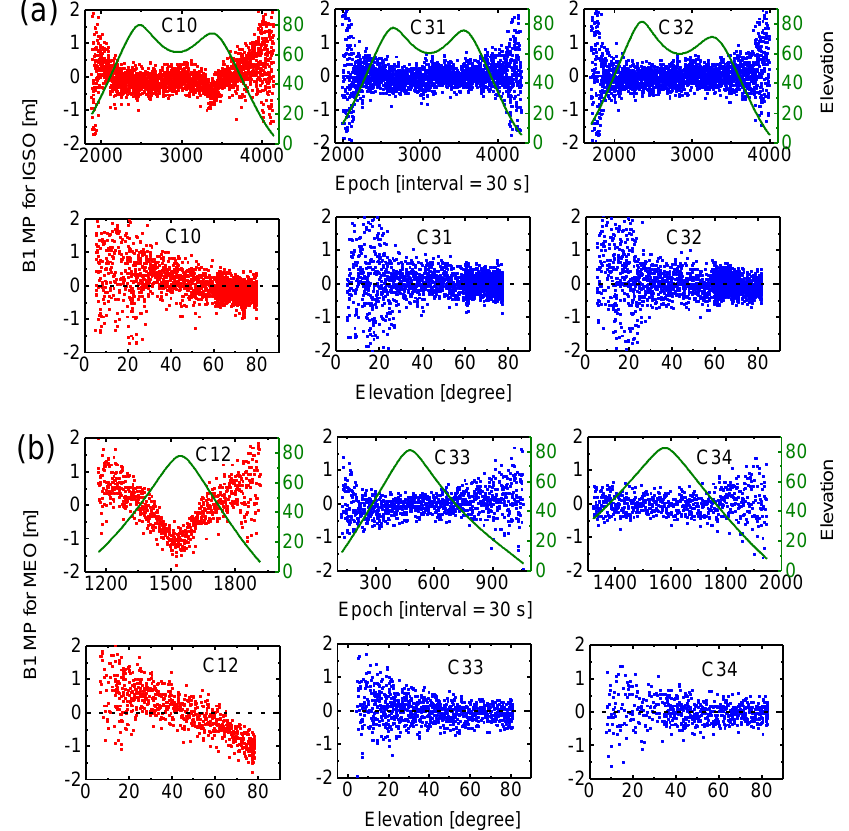
Figure 4. MP combinations of BDS-2 (red) and BDS-3 (blue) B1 frequency as a function of time and a function of elevation angle for IGSO ( a ), and MEO ( b ) satellites at station BJF1. The olive lines represent corresponding satellite elevation.